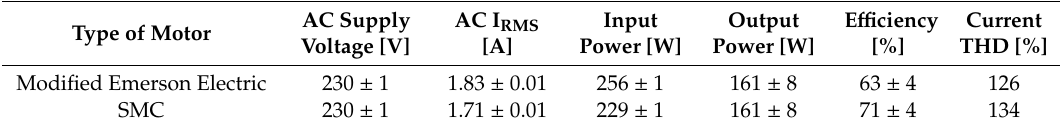
Table 3. Drive performance with modified Emerson Electric and SMC motors, for T = 0.35 Nm, n = 4400